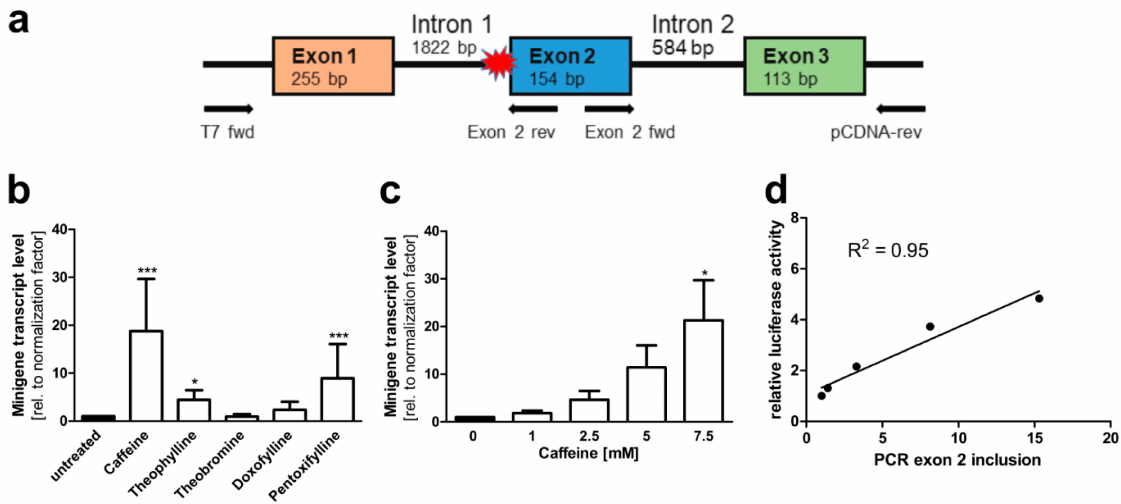
Figure 6. AGA minigene qRT-PCR splicing assay in HEK293T cells. ( a ) The AGA minigene construct without firefly luciferase, the qRT-PCR primers for detecting exon 2 inclusion are shown with arrows. ( b , c ) HEK293T cells were transfected with the minigene construct and treated with ( b ) 7.5 mM of the substances or ( c ) increasing doses of caffeine for 24 h. Total RNA was isolated, reversely transcribed and analyzed by qRT-PCR. Bars represent the mean ± SD of three independent experiments. Statistical analysis by one-way ANOVA against the untreated samples. Values of p < 0.05 were considered significant (*) while values of p < 0.001 were considered extremely significant (***). ( d ) The caffeine effect from luciferase assay (shown in Figure 5a) was correlated with the caffeine effect in the qRT-PCR assay shown in ( c ).